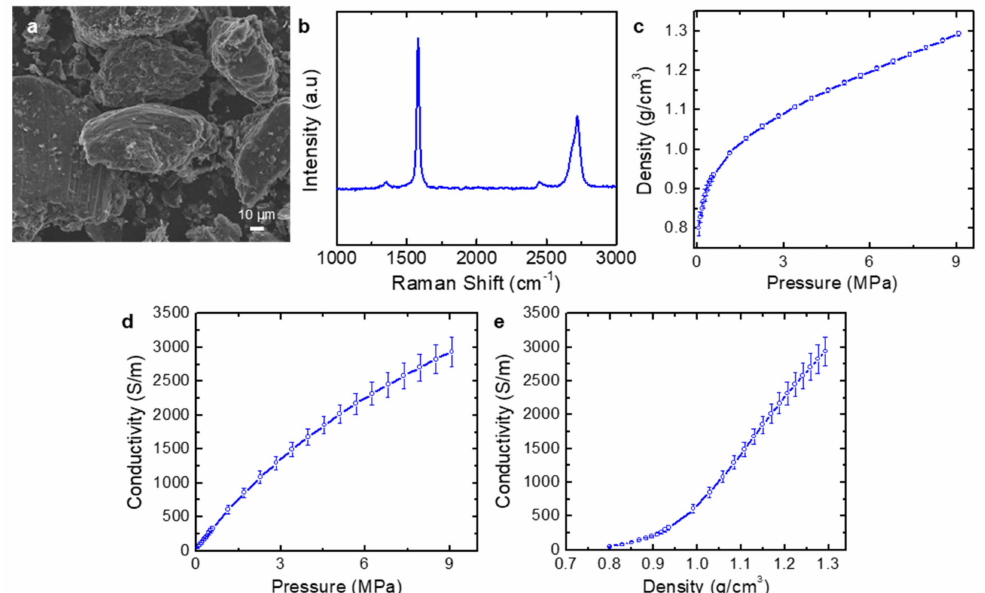
Figure 2. Characterization and electromechanical measurements of graphite (SP-2) powders. ( a ) SEM image. ( b ) Raman spectrum. ( c – e ) Electromechanical measurements of the graphite agglomerates: ( c ) density vs. pressure curve, ( d ) electrical conductivity vs. pressure curve, and ( e ) electrical conductivity vs. density